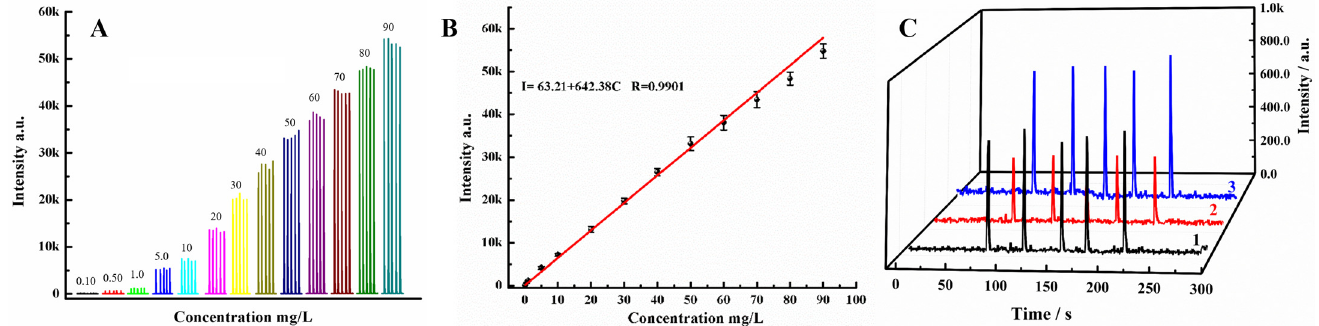
Figure 8. ( A ) CTL response of different concentrations, ( B ) the calibration plots of MSBE versus signal intensity (insert), and ( C ) CTL curves of 0.50 mg/L MSBE (line 1), 95% (wt%) MTBE samples (line 2), and after the addition of 0.50 mg/L (line 3).